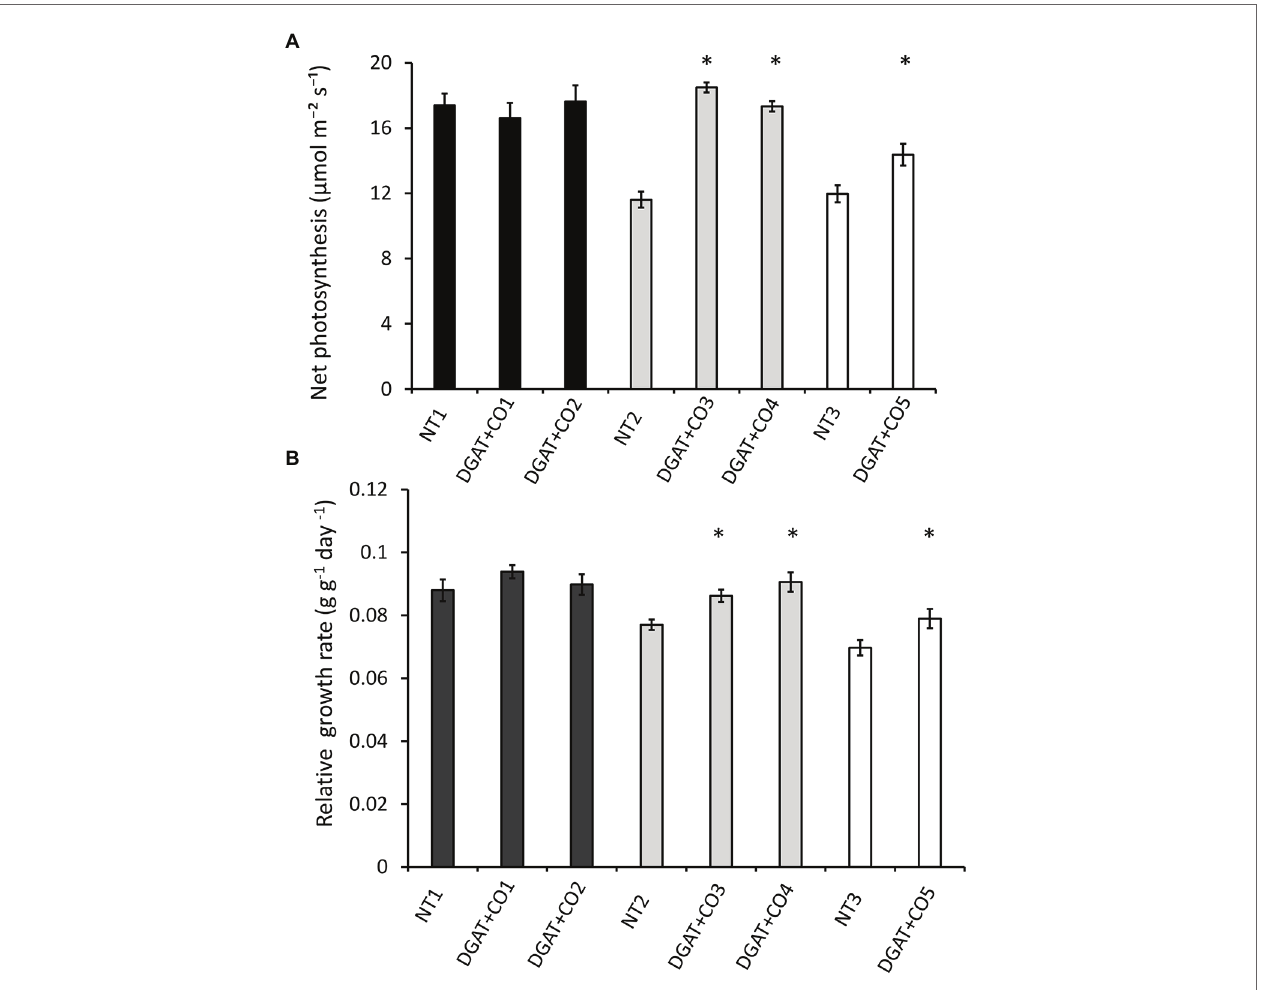
FIGURE 3 | Net photosynthesis (A) and whole-plant relative growth rate (B) for five DGAT + CO lines and three NT lines. Means ± SE. * Statistically differs from NT, p < 0.05; n = 10. Matching genetic backgrounds are shaded together.